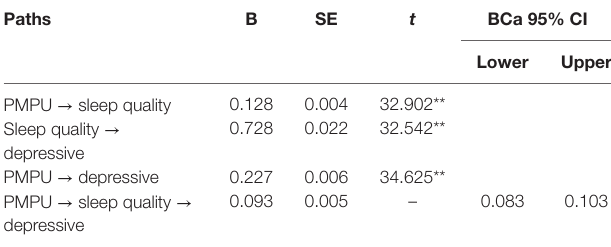
TABlE 4 | Summary of mediation analysis of sleep quality between PMPU and depressive. Paths